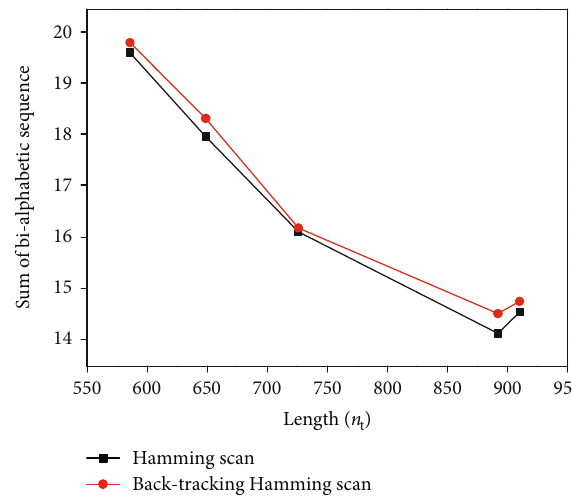
Figure 13: Comparison of Hamming scan and backtracking Hamming scan (the data were obtained from Ref.